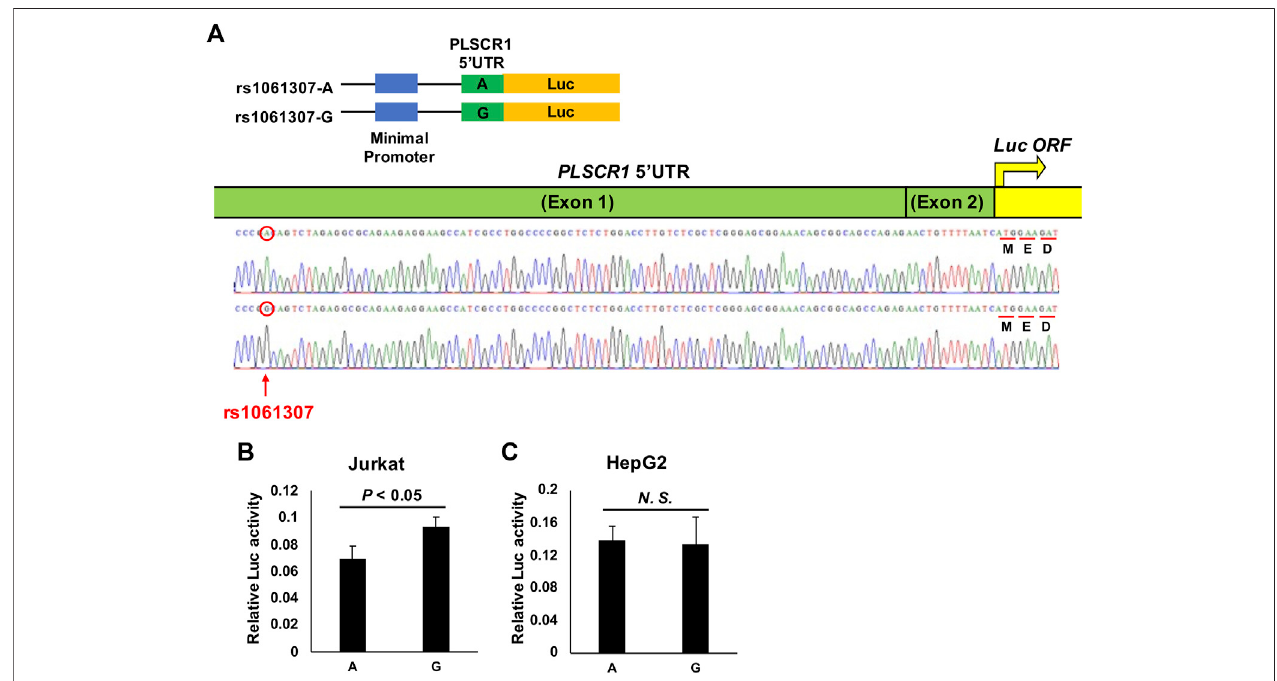
FIGURE3| Luciferaseassayfor PLSCR1 rs1061307. (A) ConstructoftheluciferasereporterpGL4.23(luc2/minP)vector. PLSCR1 5 ′ UTRwasconjugatedwithluc ORF. The transcriptional enhancing activity of these plasmid constructs was measured by assaying the luciferase (luc) activity of the transfected Jurkat (B) and HepG2 (C) cells, 24 h after transfection. The values of relative luciferase activity are shown as mean ±